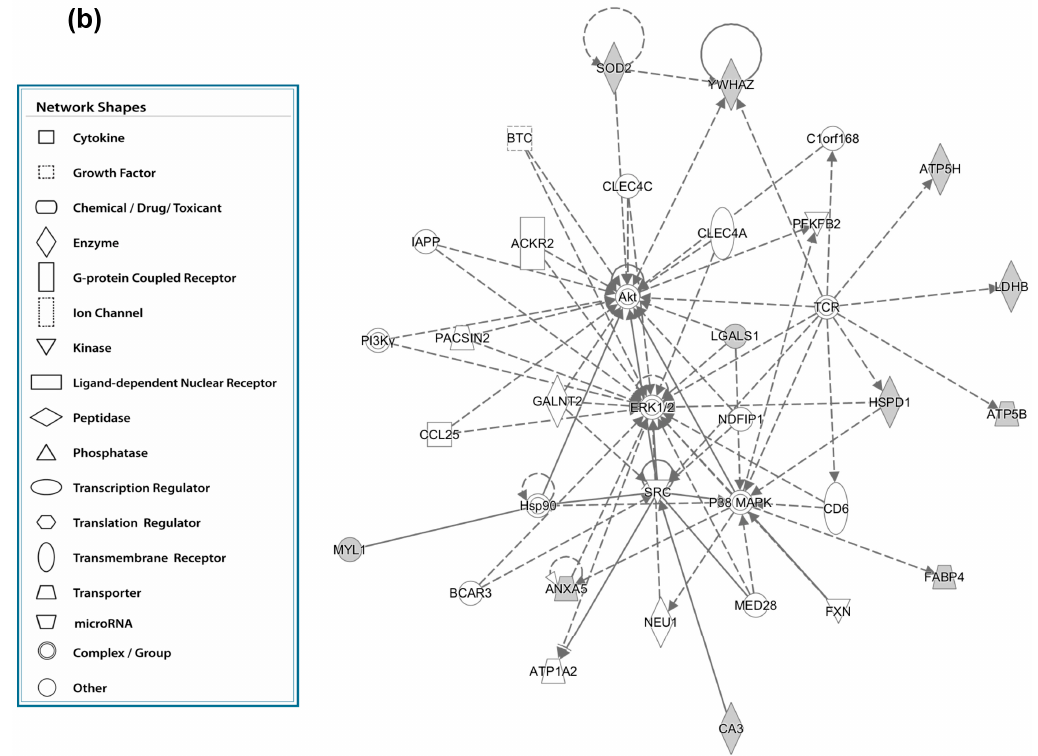
Figure 10. In silico analysis of canonical pathways ( a ) and protein interconnections ( b ) affected by 4 weeks of 3,5-T2 administration to high-fat fed rats. ( a ) The lists of differentially represented proteins in HFD-T2 vs HFD were input into the IPA platform (Ingenuity ® Systems, www.ingenuity.com) for the identification of the canonical pathways differing between the two groups. The over-represented canonical pathways for HFD-T2 vs. HFD deregulated proteins are represented in bar plots by their statistical score (negative logarithm to the base 10 of B-H corrected p -value) with a threshold of 1.3 (yellow straight line). The ratio between deregulated and all proteins of a pathway is also reported (yellow not straight line). ( b ) Network representation of the molecular relationships between identified, differentially represented VAT proteins in HFD-T2 vs. HFD (Ingenuity ® Systems Ltd.). Gene products are represented as nodes, and the biological relationship between two nodes is represented as an edge (line). Indirect interactions without physical contact appear as broken lines, whereas direct interactions requiring direct physical contact between nodes appear as solid lines. All edges shown are supported by at least 1 reference from the literature, from a textbook, or from canonical information stored in the Ingenuity Pathways Knowledge Base. Human, mouse, and rat orthologs of a gene are stored as separate objects in IPKB, but are represented as a single node in the network. For clarity, network shapes are shown. BTC = Betacellulin; C1orf168 = Chromosome 1 Open Reading Frame 168; CLEC4C = C-type lectin domain family 4 member C; CLEC4A = C-type lectin domain family 4 member A; ACKR2 = Atypical Chemokine Receptor 2; IAPP = Islet Amyloid Polypeptide; PFKFB2 = 6-phosphofructo-2-kinase/fructose-2,6-biphosphatase 2; PACSIN2 = Protein Kinase C And Casein Kinase Substrate In Neurons 2; GALNT2 = Polypeptide N-Acetylgalactosaminyltransferase 2; CCL25 = C-C Motif Chemokine Ligand 25; NDFIP1 = Nedd4 Family Interacting Protein 1; CD6 = Cluster of Differentiation 6; Hsp90 = heat shock protein 90; BCAR3 = Breast Cancer Anti-Estrogen Resistance 3; ATP1A2 = ATPase Na+/K+ Transporting Subunit Alpha 2; NEU1 = Neuraminidase 1; MED28 = Mediator Complex Subunit 28; FXN = Frataxin; PI3Kgamma = Phosphoinositide 3-kinase gamma; MAPK = Mitogen-activated protein kinase; TCR = T-cell receptor; SRC = Proto-oncogene tyrosine-protein kinase.